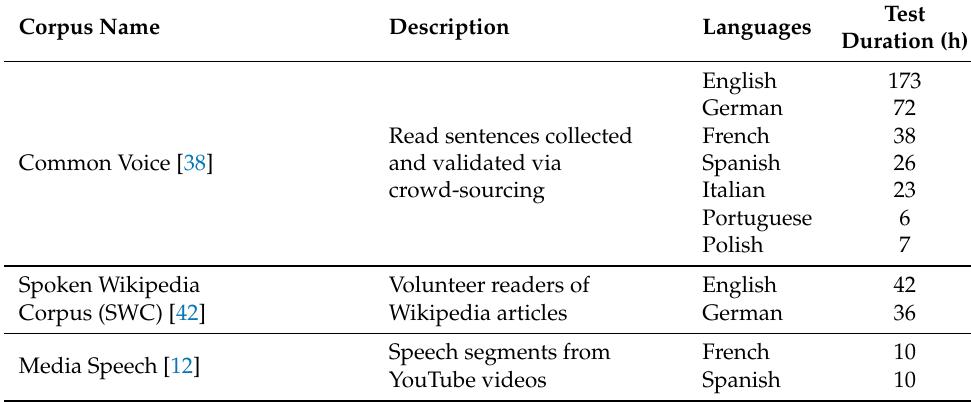
Table 1. List of public speech corpora considered to test the performances of ASR and KWS systems based on Wav2Vec2.0 and